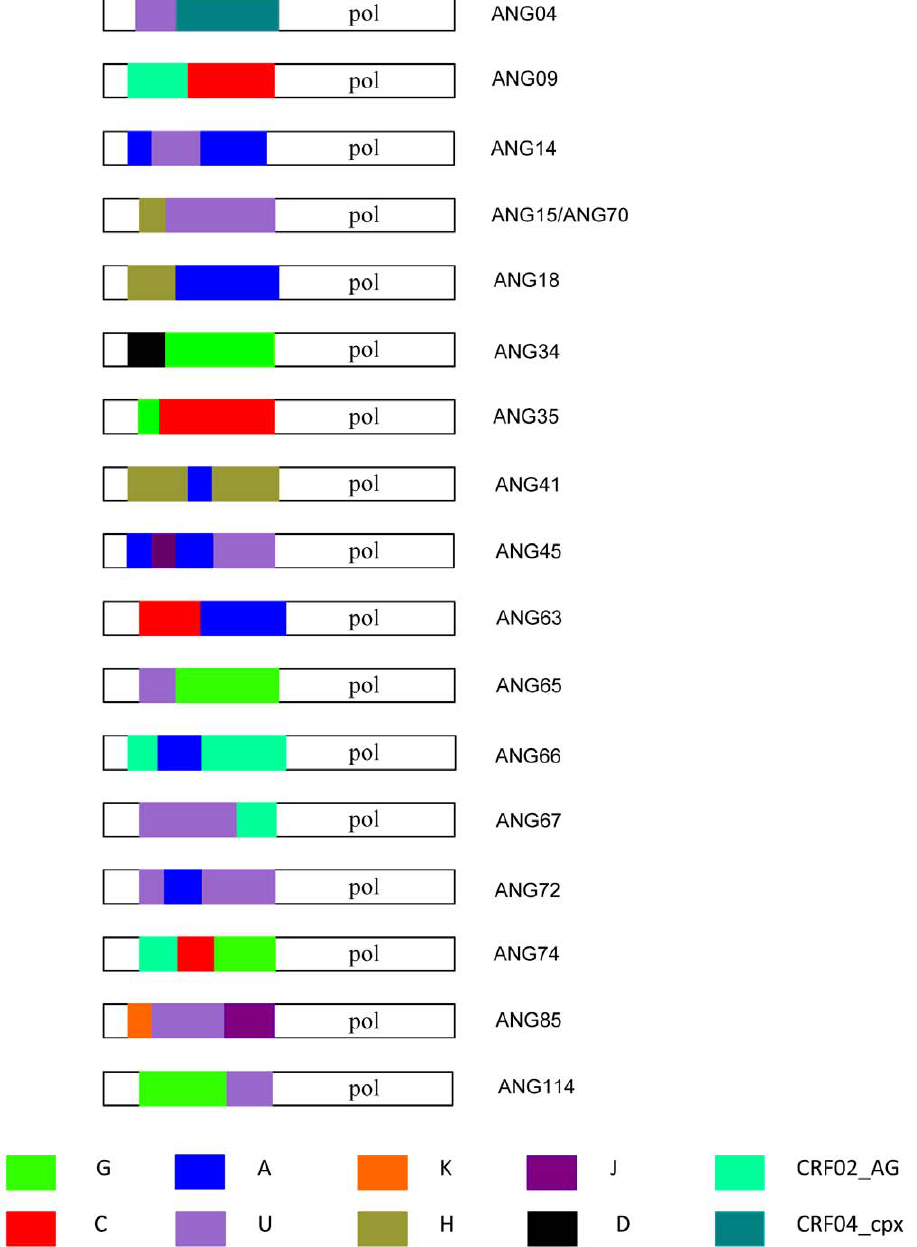
Figure 3. Schematic drawing showing breakpoint pattern at the pol (PR/RT) region of the HIV-1 URFs found in Angola. Breakpoint positions were obtained using bootscanning and phylogenetic analyses. The pol gene is colored according to the subtype as shown in the figure legend. The fragments not analyzed are represented in white.